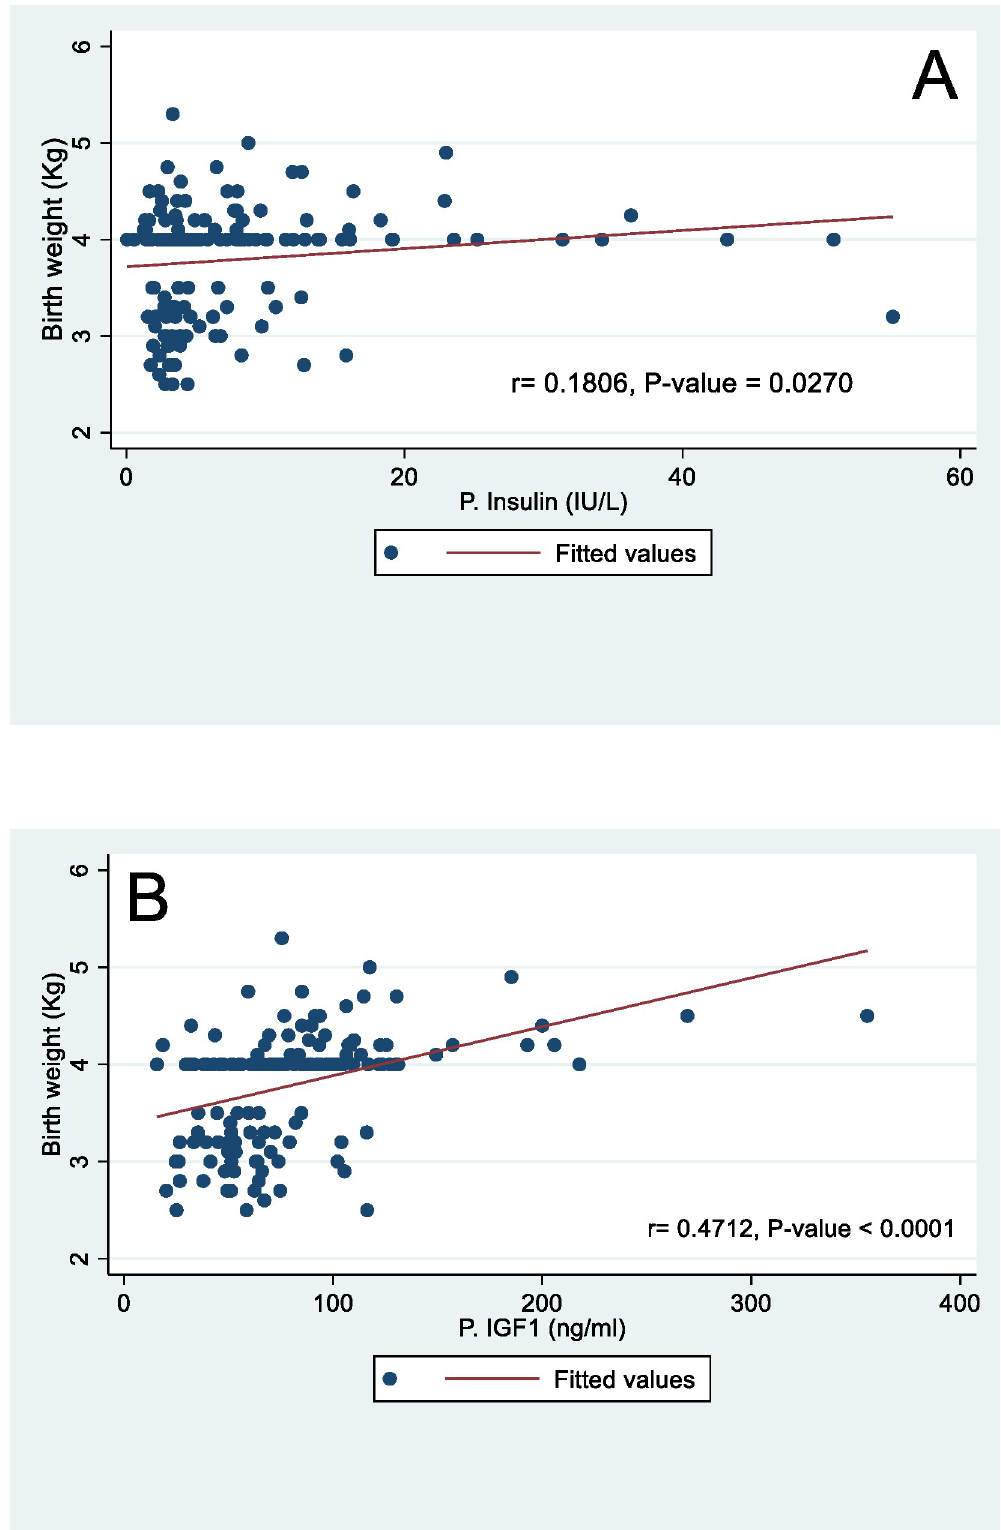
Fig 2. Spearman’s correlation coefficient of cord blood insulin and IGF-1 with birth weight.